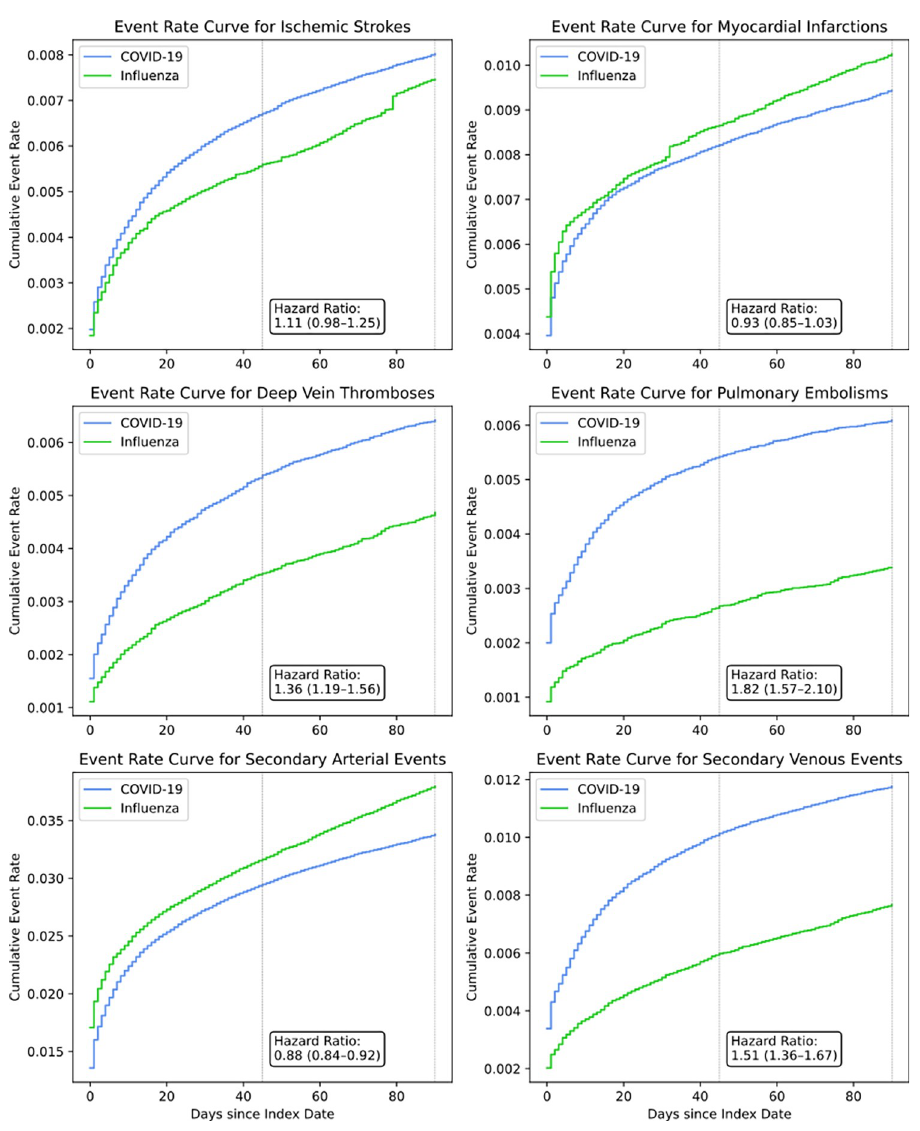
Fig 3. Propensity-weighted cumulative event rate curves for secondary outcomes. Hazard ratios with 95% confidence intervals are shown. After weighting, cohorts were balanced across 49 covariates including demographics, medication use, and clinical comorbidities associated with arterial and venous